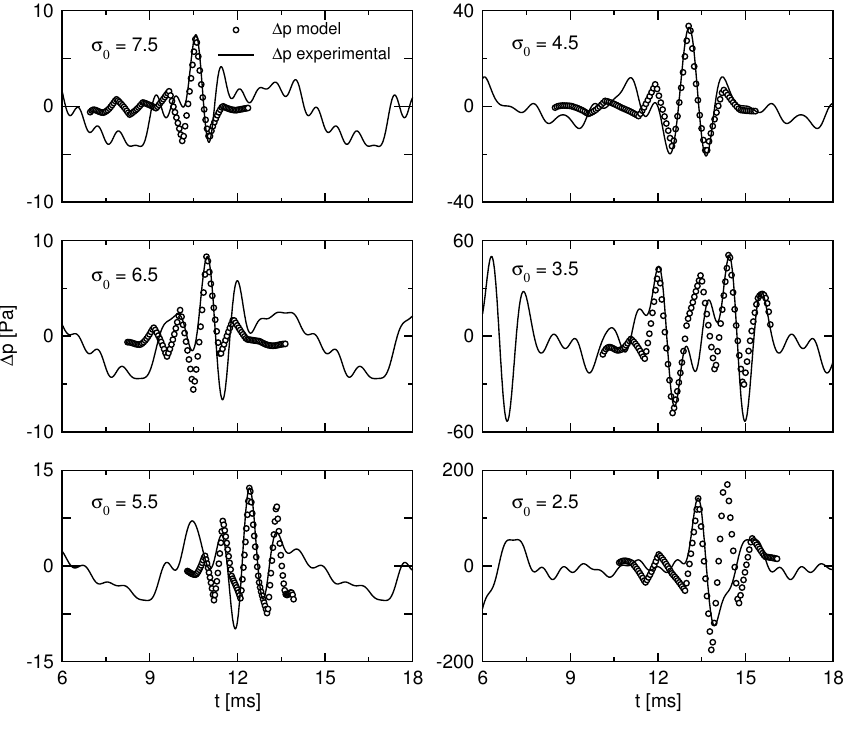
Figure 14. Comparison between reduced-order ∆ p ( ) from measurements and computed ∆ p ( ◦ ) from volume acceleration as per Equation